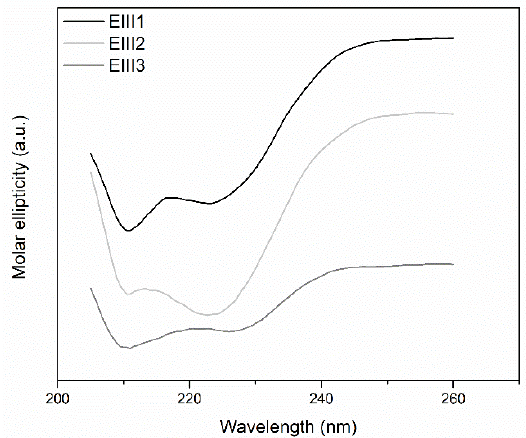
Figure 4. CD spectra of DrEndoIII 1, 2 and 3. The differences observed between the CD spectra of the wild-type enzymes are related to different concentrations used for each protein in order to obtain a spectrum (0.15 mg mL − 1 for DrEndoIII1 and 2 and 0.05 mg mL − 1 for DrEndoIII3).